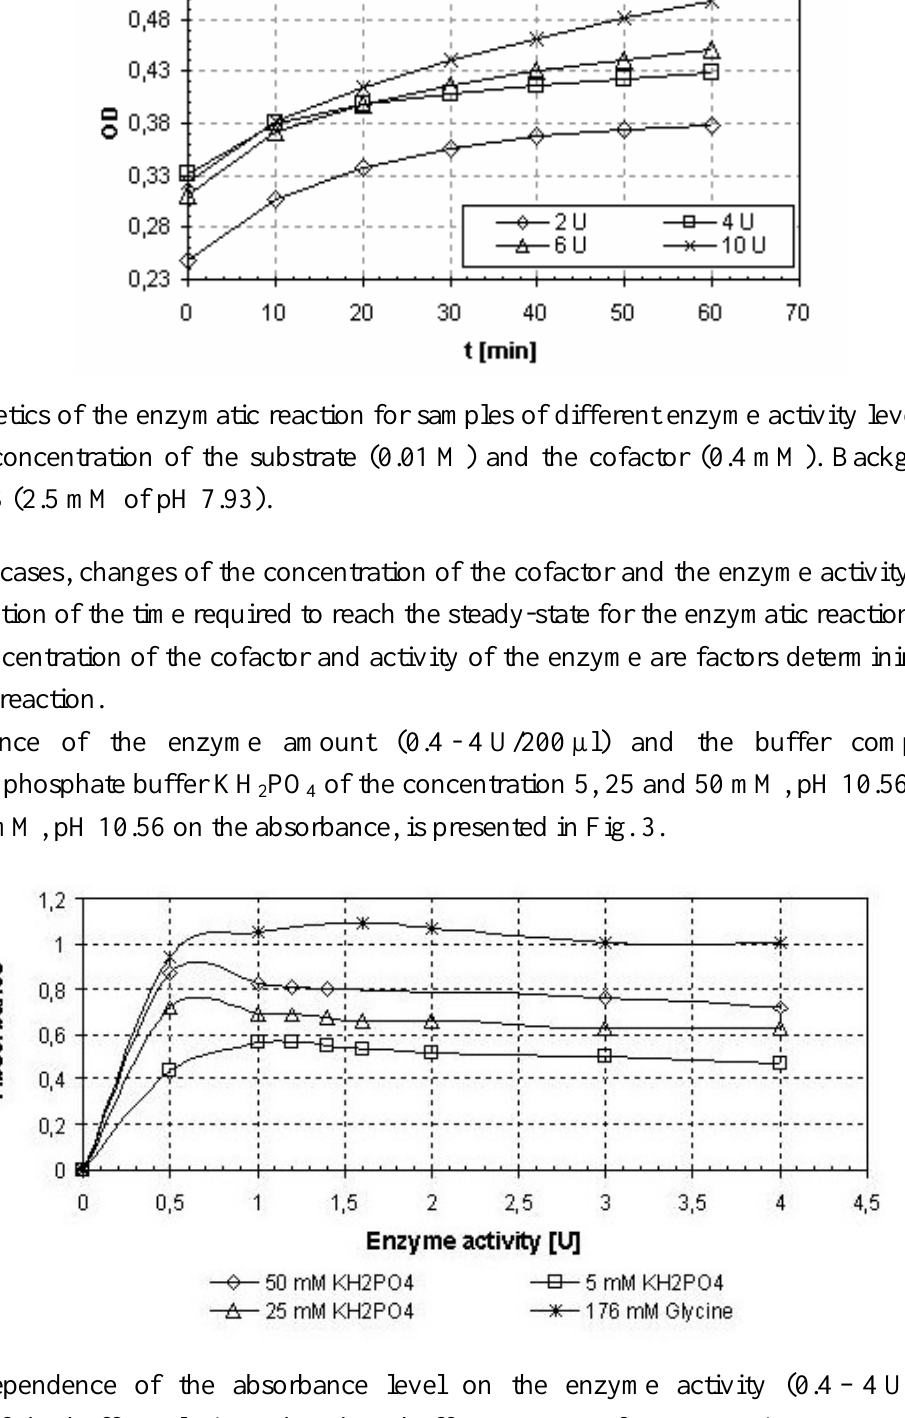
PO of concentration 5, 25 and 50 mM of 2 4